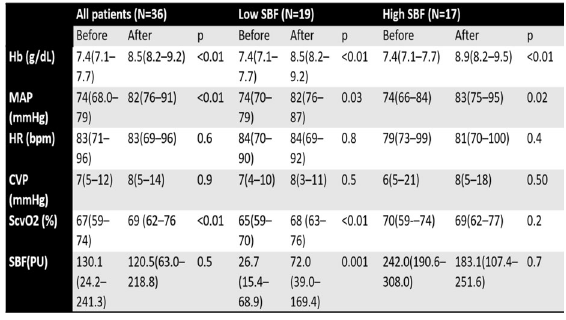
Table 1 (abstract 001107). Hemodynamic and oxygenation variables before and after RBCT in patients with lower and higher baseline skin blood